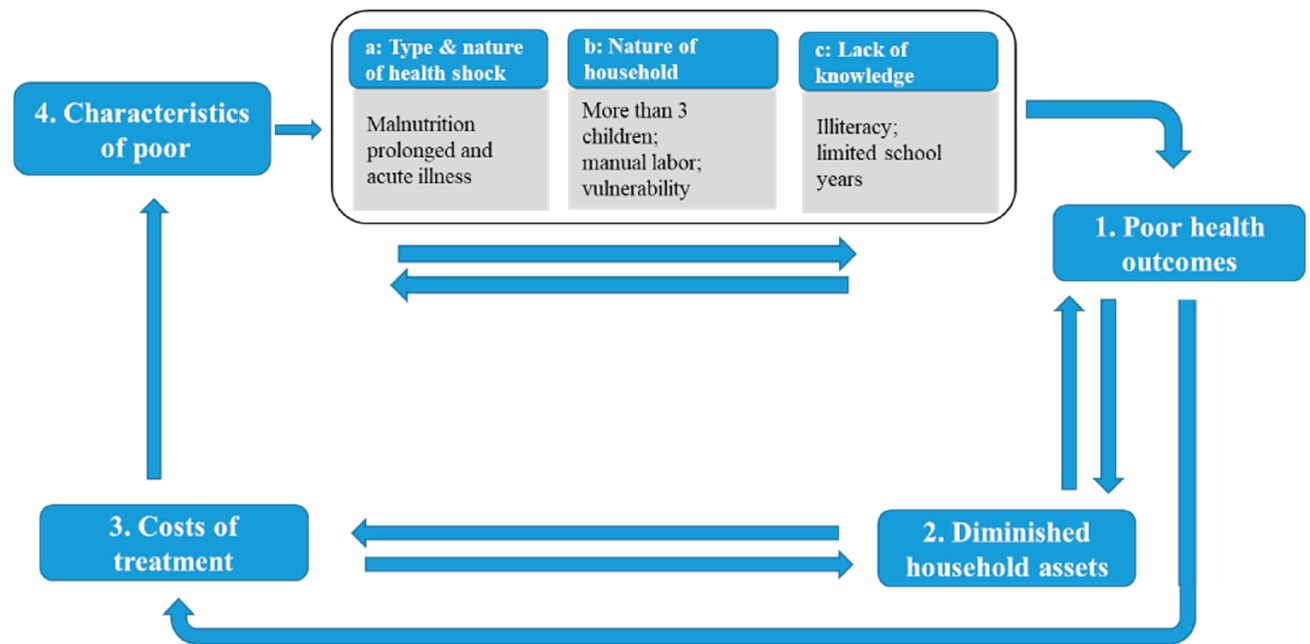
Figure 2. Conceptual framework for the vicious cycle of poverty and illness in South Xinjiang, China.